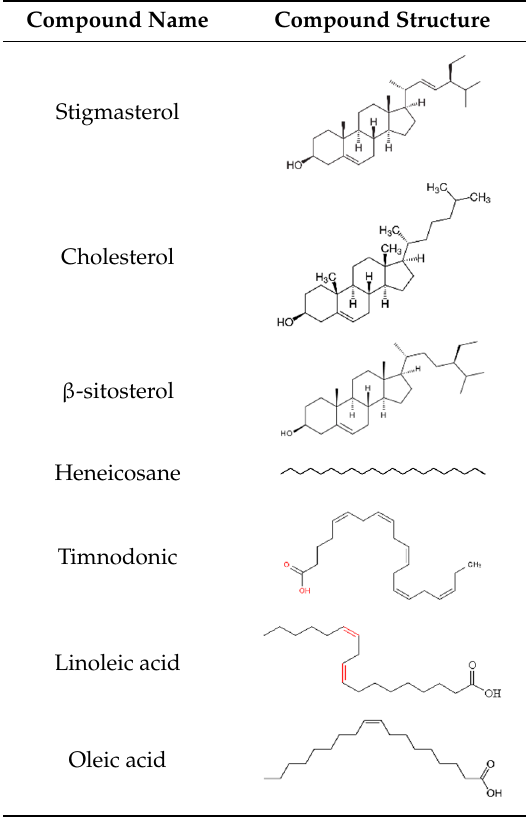
Figure S1: Variation of surface coverage with temperature plots for carbon steel in two acids in presence 5% ASMS. Figure S2. Transition state plots for carbon steel in two acids in absence and presence 5%